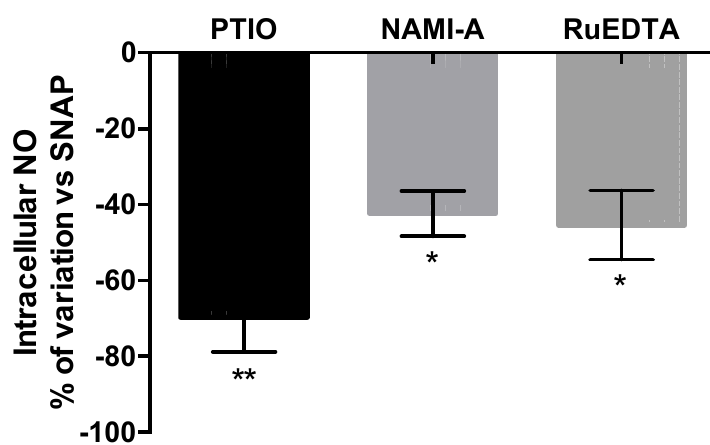
Figure 10. Effects of the post-treatment with NAMI-A, Ru-EDTA, and PTIO on SNAP induced NO production/release by EA.hy926 cells. EA.hy926 cells were pre-treated with 10 − 4 M SNAP for 2 h and then, after washing, with NAMI-A, Ru-EDTA, and PTIO for further 2 h. Then, NO was measured at intracellular level by the fluorescent dye DAF-2 DA. Data are expressed as per cent of variation vs. SNAP treated cells and are the mean ± S.E.M. of five samples per group. ANOVA and Tukey–Kramer: * p < 0.05, ** p < 0.01 vs. Control.